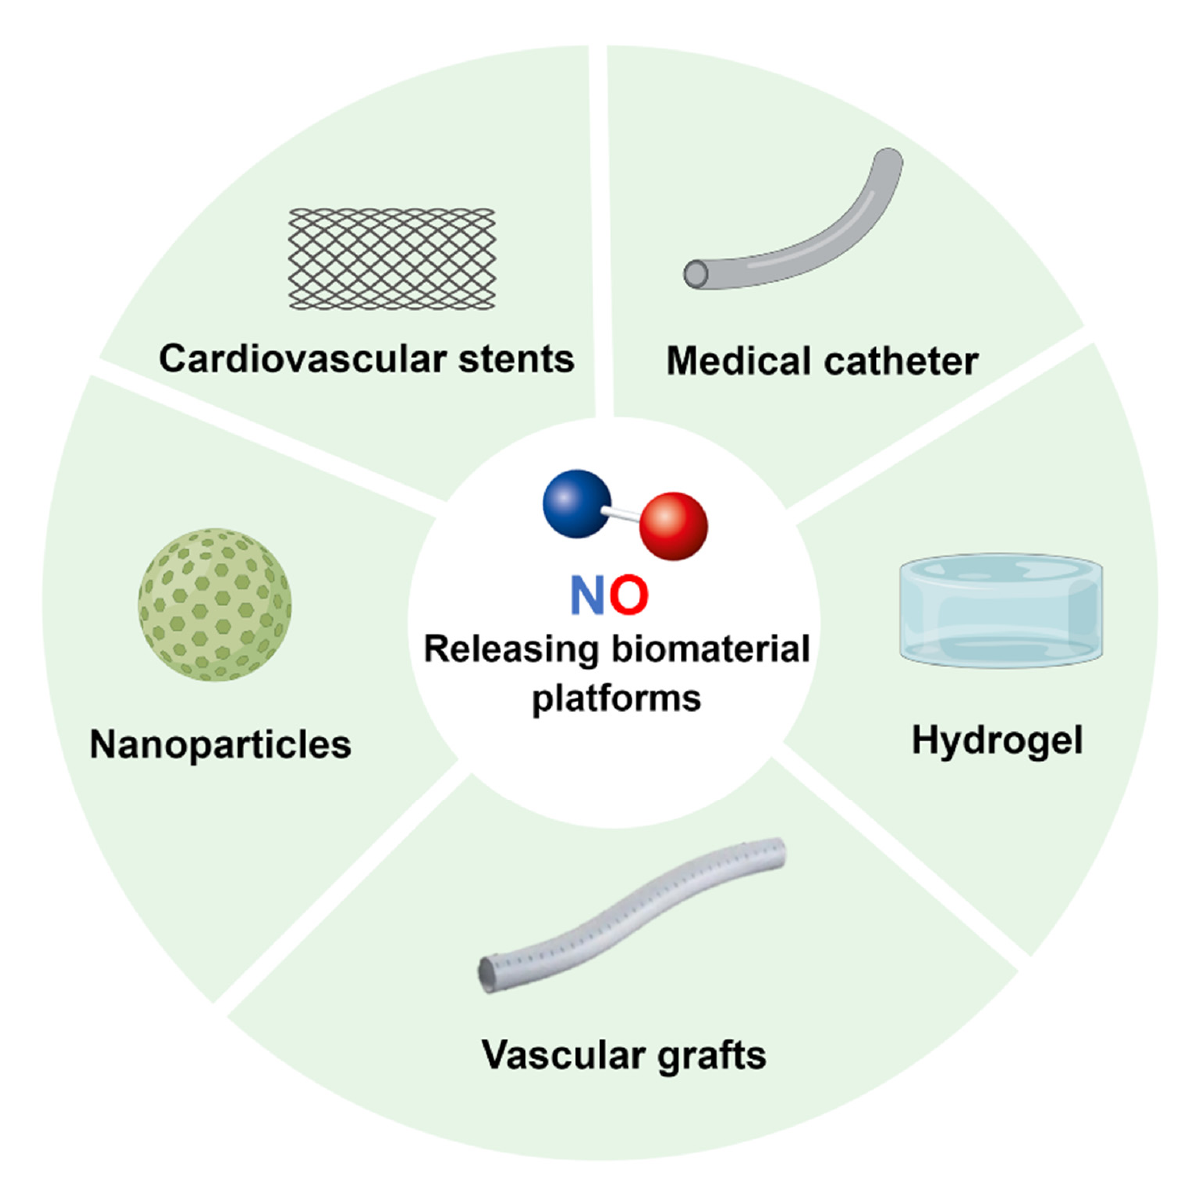
Figure 3. A schematic summary of the different biomaterial platforms that have been engineered to store and release NO for CVD treatments.